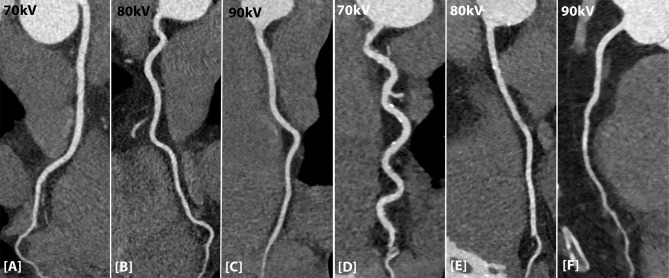
Attenuation profile in the RCA for the high pitch and AS protocol and different kV settings.[A-C] Attenuation in the RCA of the high pitch protocol for the three different kV settings. [D-F] Attenuation in the RCA for the AS protocol for the three different kV settings.